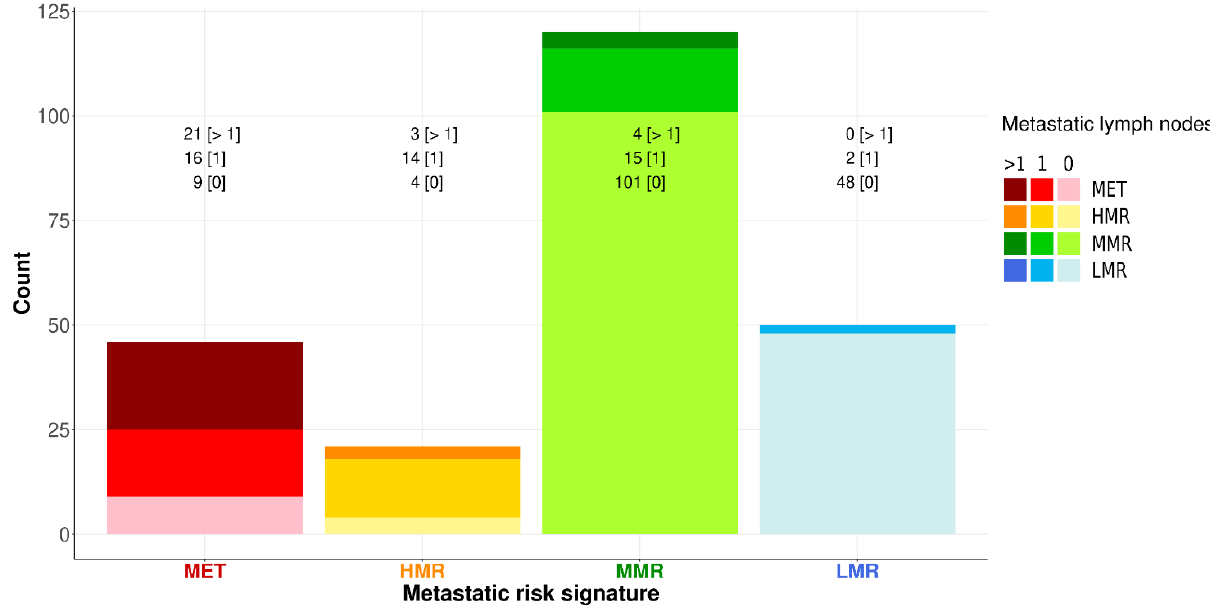
Figure 5. Metastasis risk signatures (MRSs) and the number of positive nodes.